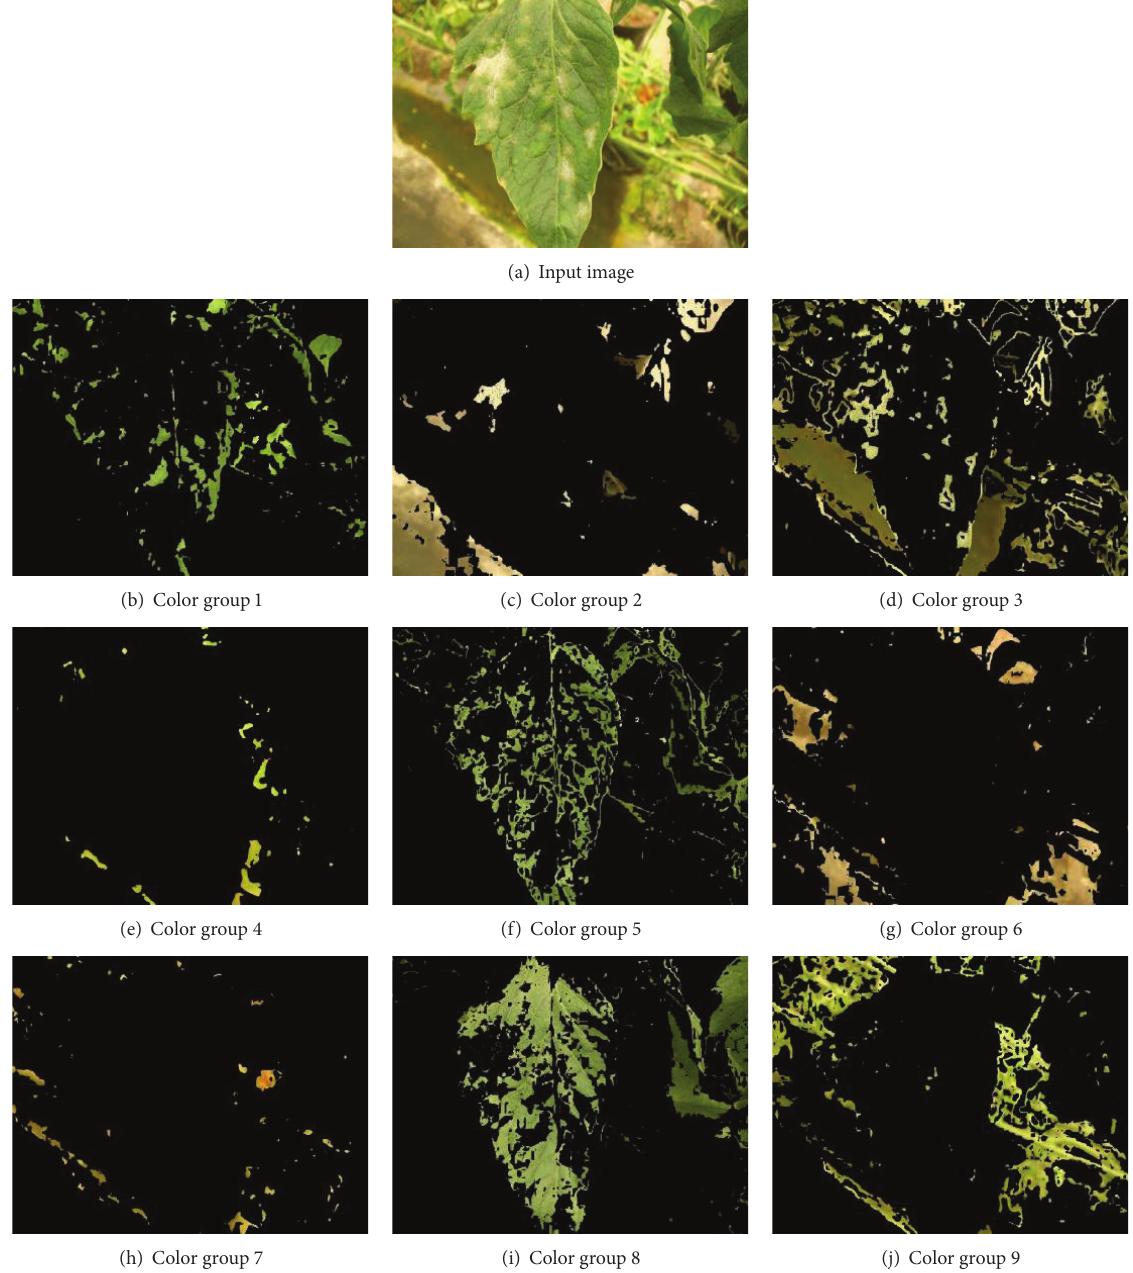
Figure 3: Images generated for the different color groups from an input image. The presented color groups correspond to 2nd iteration of